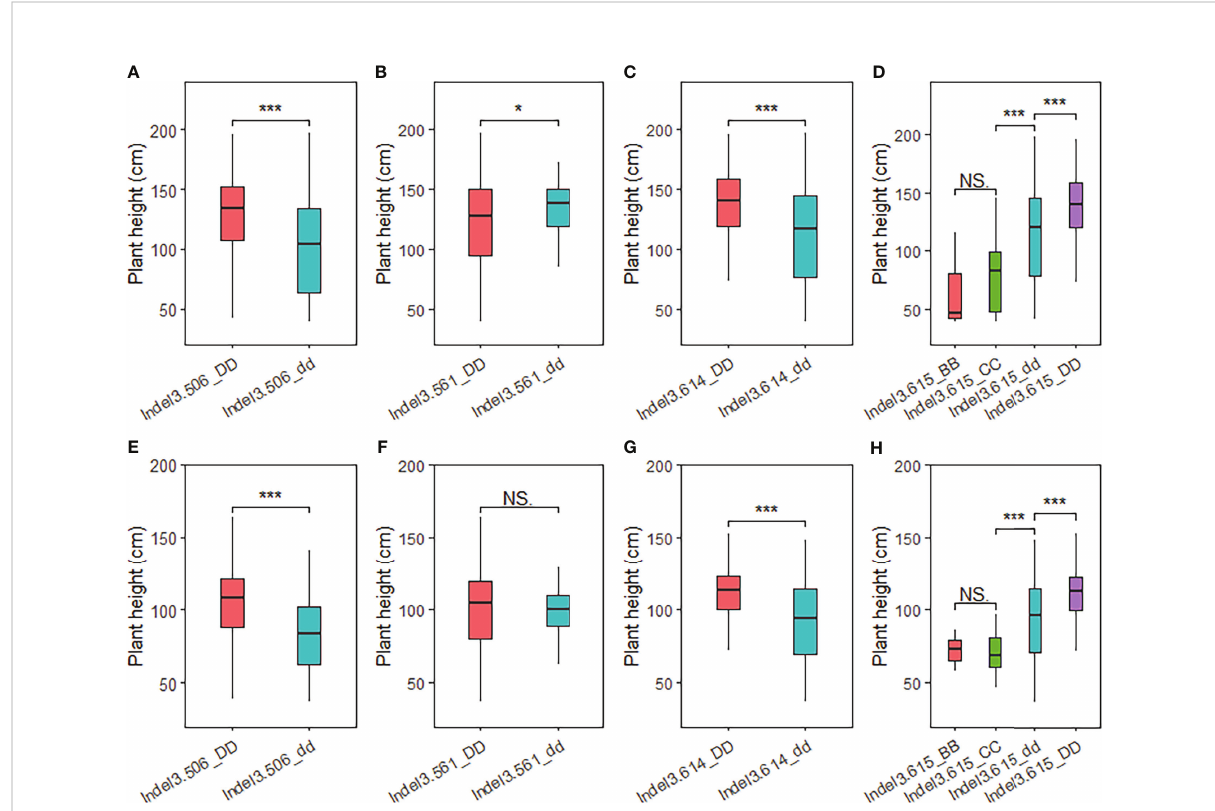
FIGURE 5 Association test of plant height in the natural population using insertion – deletion (Indel) markers in the PH1.1 interval. (A – H) Association tests of 512 broomcorn millet accessions in 2020 and (A – D) and 2021 (E – H) . *, *** represent signi fi cant differences at P < 0.05 and 0.001, respectively. NS indicates no signifcant